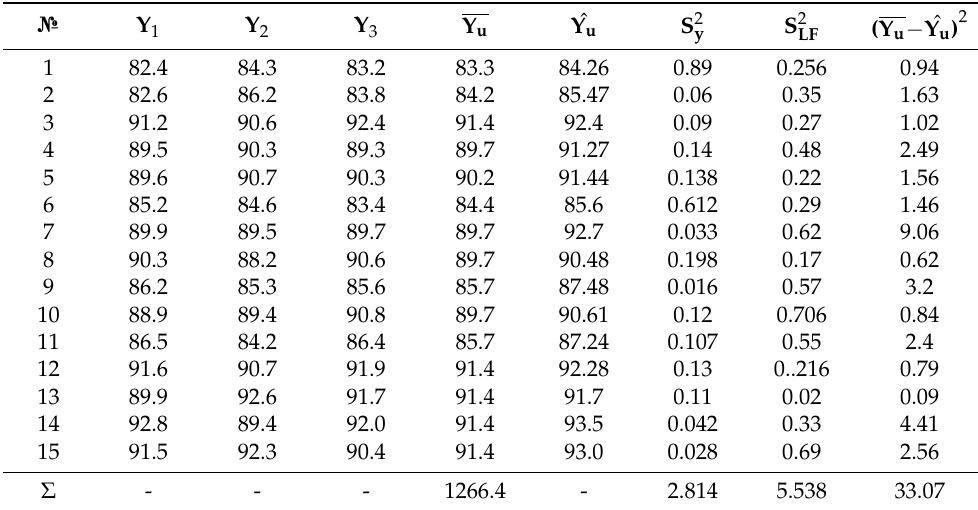
Table 2. Statistical characteristics of the errors in the